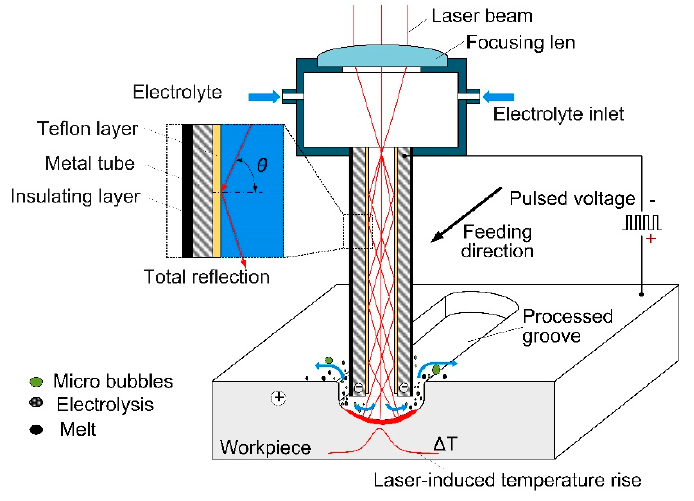
Figure 1. Mechanism of synchronous laser and shaped tube electrochemical milling (Laser-STEM).